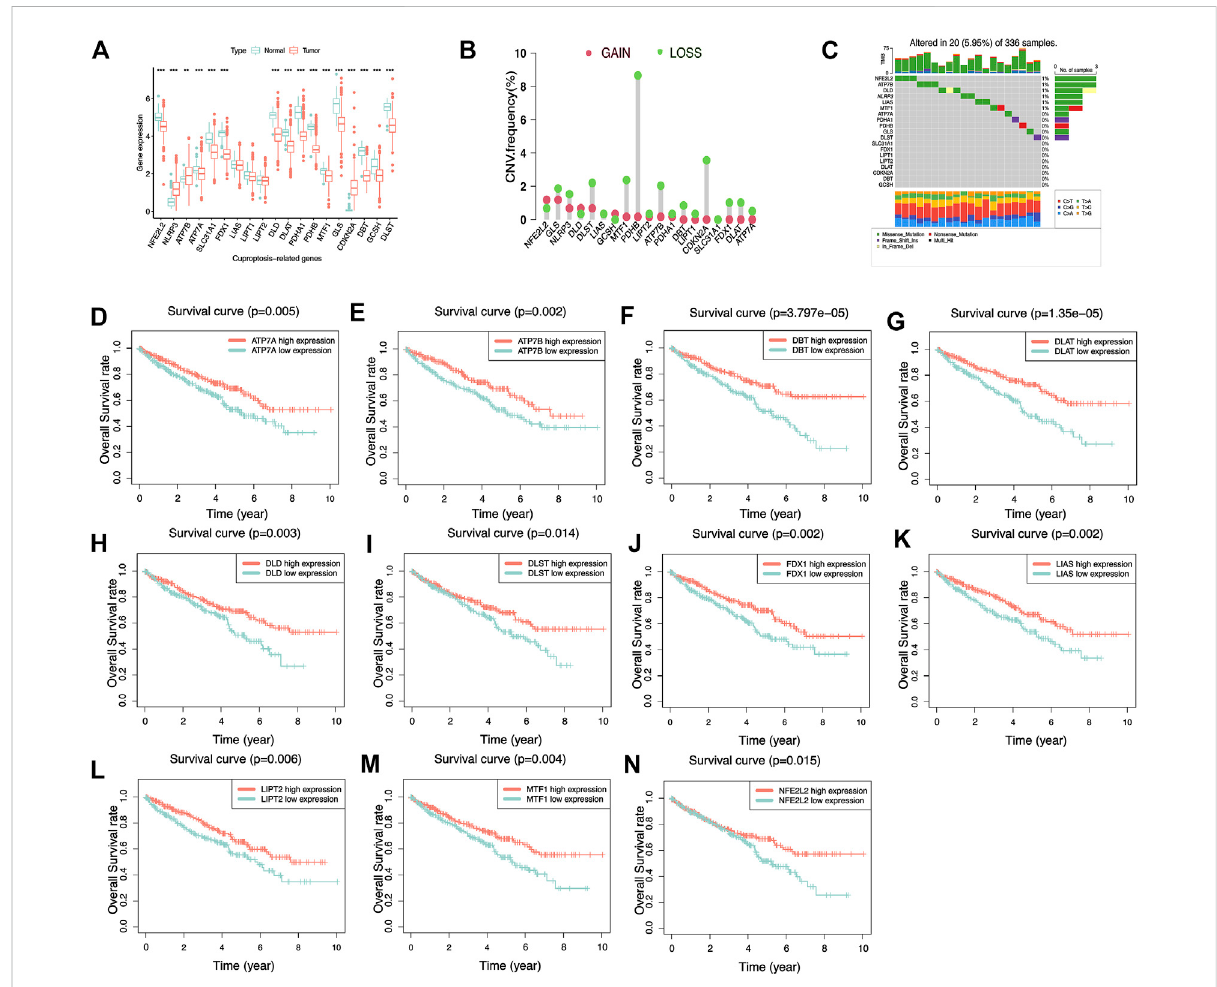
FIGURE 2 Biological characteristics of 19 cuproptosis-related genes. (A) Differential expression of cuproptosis-related genes in KIRC and normal renal tissues. ** p < 0.01, *** p < 0.001. (B) Copy number variation frequency plots showed that most cuproptosis- related genes had copy number deletions. (C) The waterfall plot shows the frequency of cuproptosis-related genes mutations in KIRC. The different colored squares at the bottom represent different types of mutations. (D – N) K – M survival curves of cuproptosis- related genes in KIRC. Most of the cuproptosis-related genes in KIRC have prognostic signi fi cance and act as an adverse prognostic